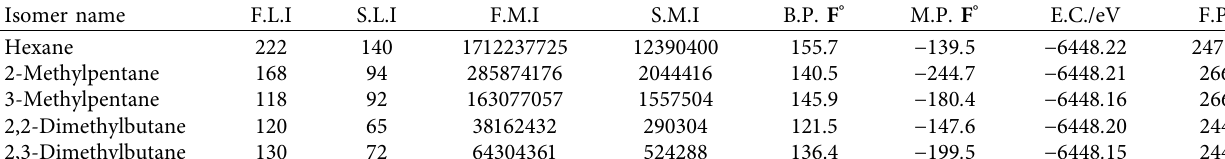
Table 1: Hexane and its isomers with their physico-chemical properties and topological indices values. Isomer name